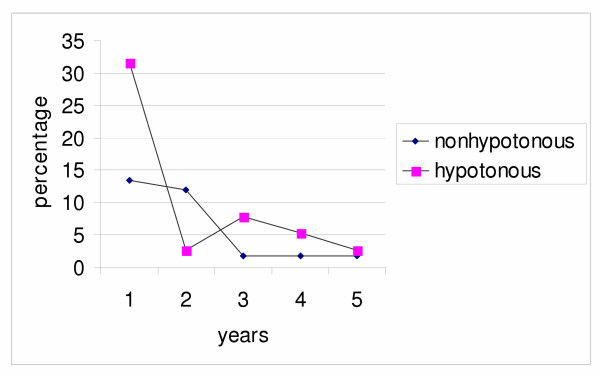
Percentage Of New Failures Of Trabeculectomies Each Year Post surgery.